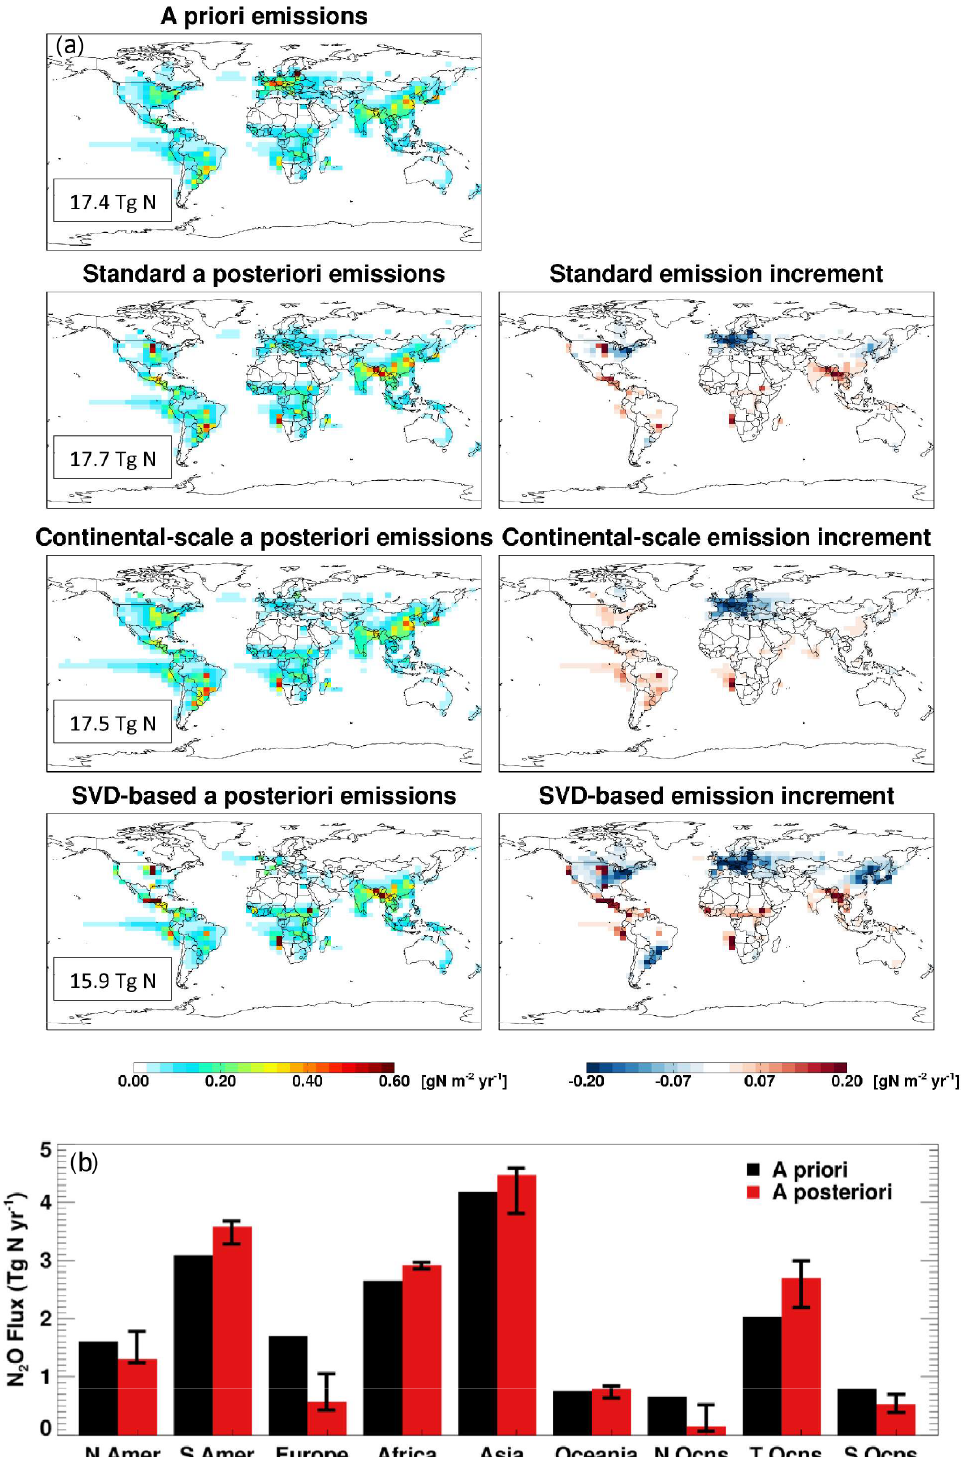
Figure 3. (a) Left panels: 2011 annual N 2 O emissions for the a priori database and a posteriori results for each of the inversion frameworks used here (standard 4D-Var, continental-scale inversion, SVD-based inversion). Global fluxes are shown inset in each map. Right panels: annual posterior emission increments relative to the a priori database for each inversion framework. (b) 2011 annual N 2 O flux over six continental and three oceanic regions for the a priori database (black) and the a posteriori median from the three inversion frameworks (red). Error bars denote the range of a posteriori values for each